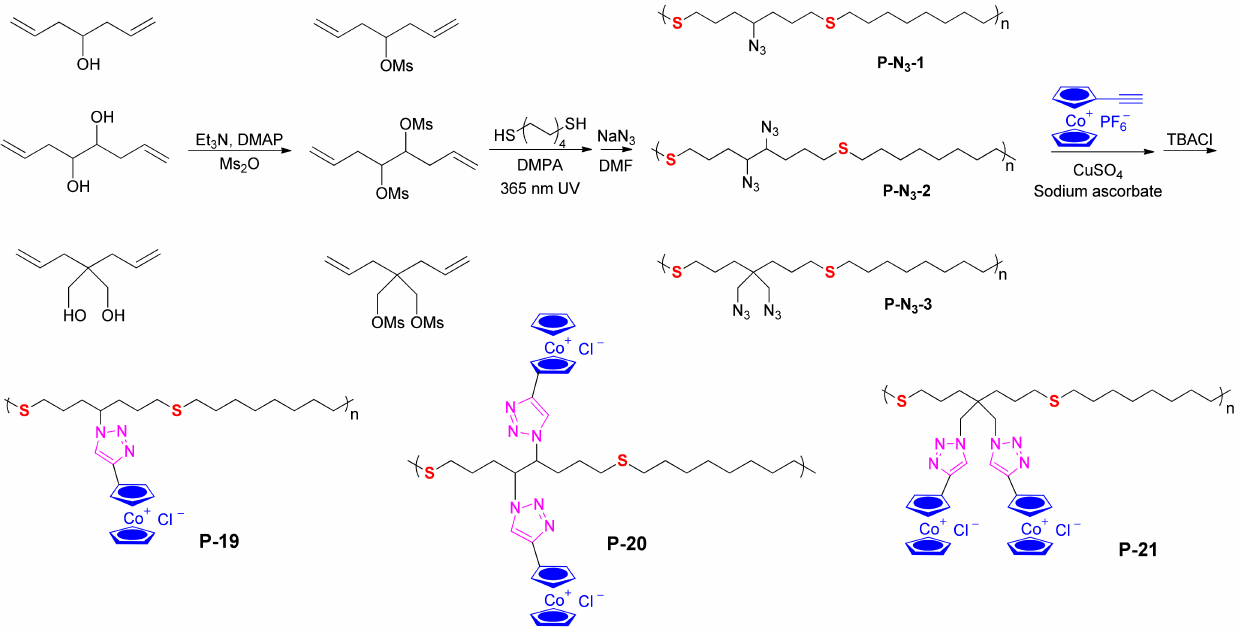
Figure 7. Synthetic procedure for cobaltocenium-containing polythioether type inhibitors: P-19/P- 20/P-21 [69].